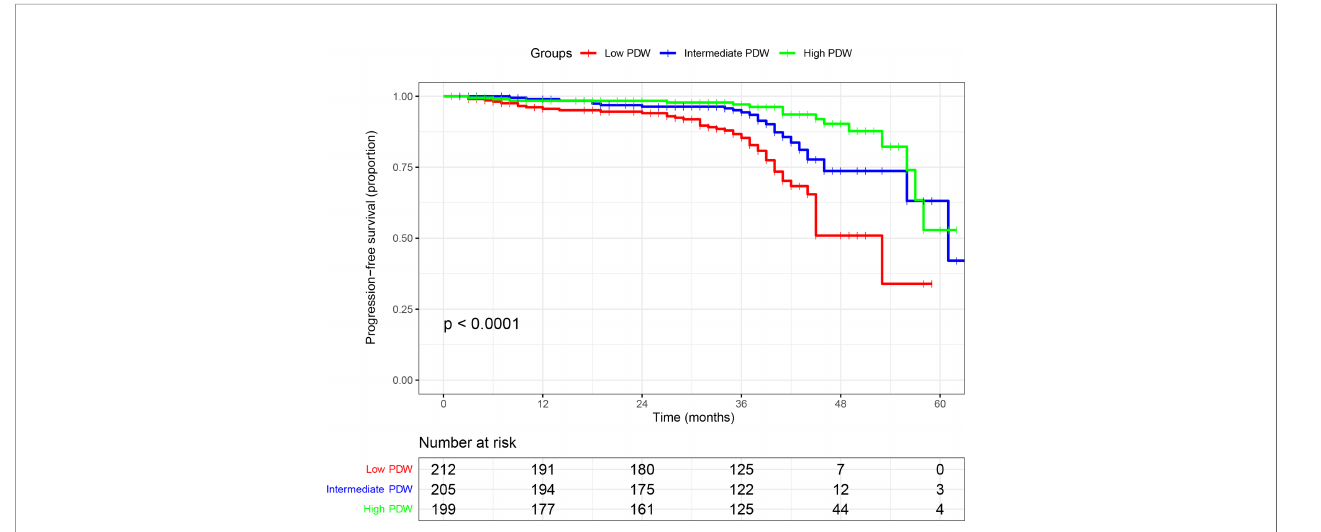
FIGURE 1 | Kaplan – Meier curve of progression free survival in nonmetastatic renal cell carcinoma strati fi ed according to platelet distribution width.